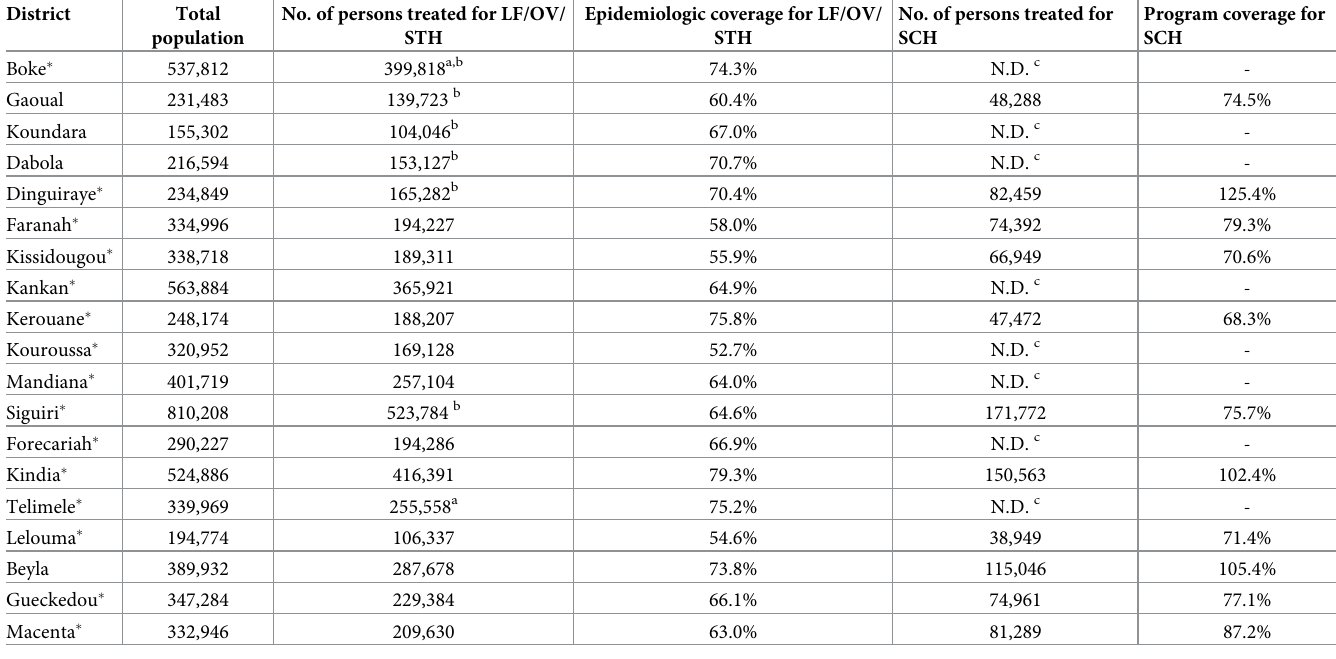
Table 1. MDA coverage results in 19 health districts in 2020 in Guinea.